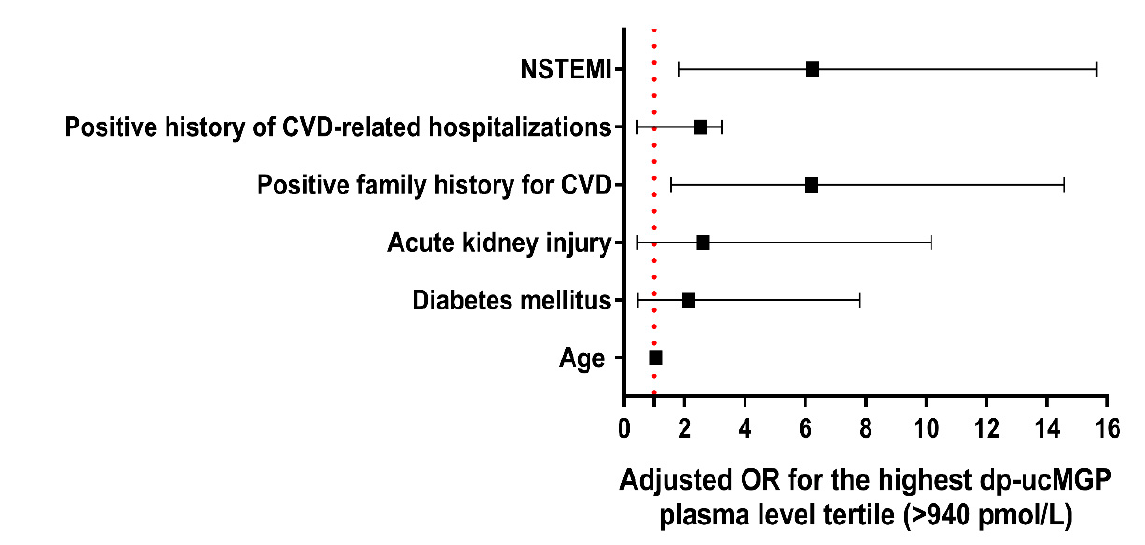
Figure 3. Predictors of the highest tertile of dp-ucMGP plasma levels (>940 pmol/L) after covariate adjustment in the stepwise multivariable regression model. Abbreviations: CVD: cardiovascular disease; OR: odds ratio; NSTEMI: non-ST- elevation myocardial